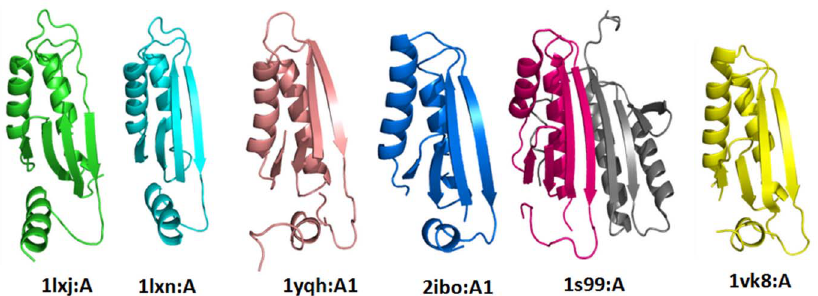
Figure 10. Structural view of members of MTH1187/YkoF-like superfamily. The domain1S99:A has internal repeat of bab fold highlighted in grey colour.